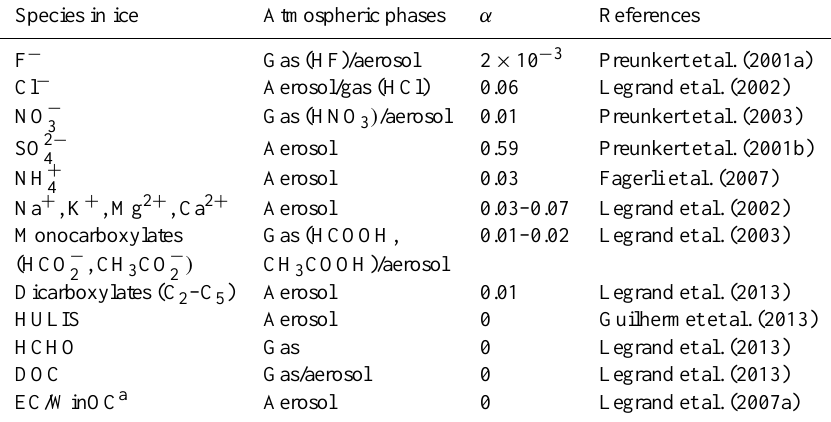
Table 1. Summary of chemical species (or fractions) that were investigated on a continuous (or quasi-continuous) and seasonally resolved basis along CDD ice cores, its physical state in the atmosphere, and references of the respective original studies. For a species X , the α value corresponds to the estimated ratio of X to calcium mass in Saharan dust (Preunkert, 2001). They were used to correct concentrations